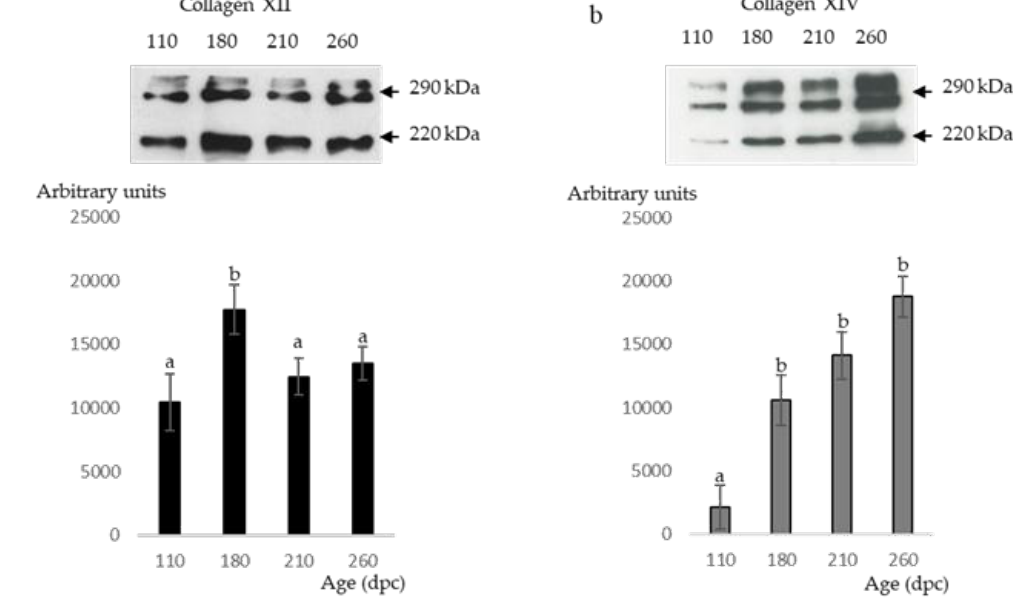
Figure 5. ( a ) Collagen XII and ( b ) Collagen XIV Western blot analysis of foetal Semitendinosus muscle at 110, 180, 210 and 260 days post-conception (dpc). The monoclonal antibodies against collagen XII and XIV, two disulphide bonded polypeptides, recognized three bands on Western blots of bovine muscle extracts, one band at 220 kDa and two others at about 290 kDa. The presence of these three bands was due to the fact that migration conditions were reducing. The relative amounts of collagen XII and XIV (least square means ± standard error of the mean) were expressed in arbitrary units. Different letters on the same graph indicated that relative amounts of collagen XII and XIV differed significantly between foetal stages ( p < 0.05).